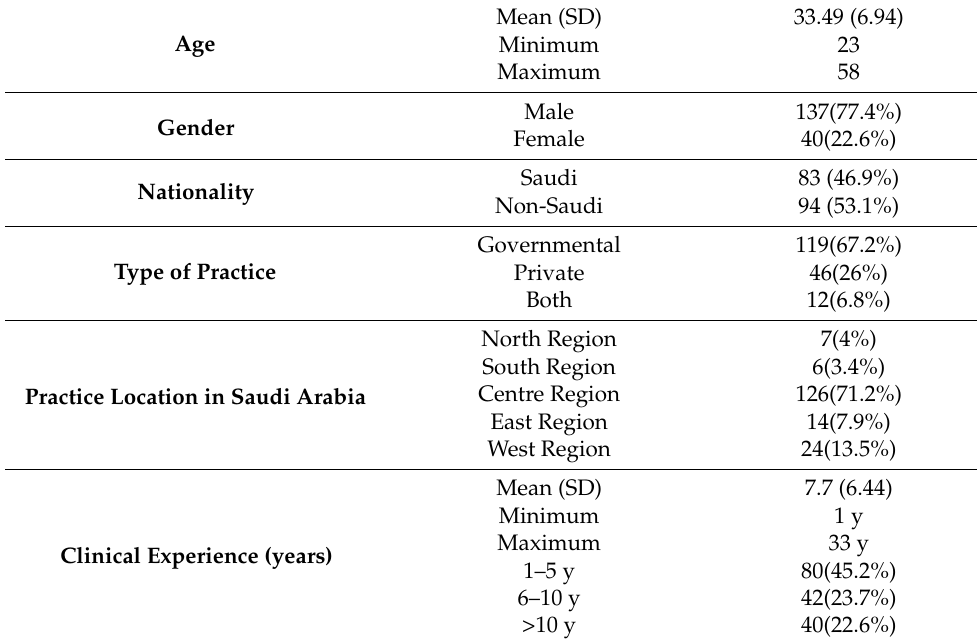
Table 1. Characteristics of participating dentists (No =